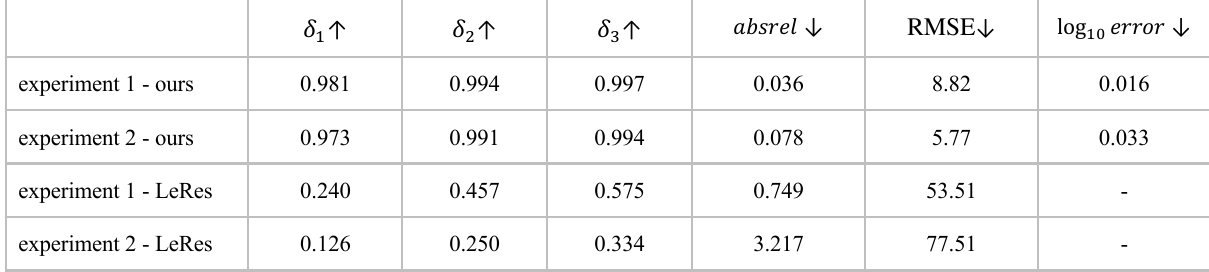
Table 1. 2D metric for experiments 1 and 2. The first two rows refer to depth map inference using our training model, while the last two refer to depth maps predicted using the trained model of Yin et al.